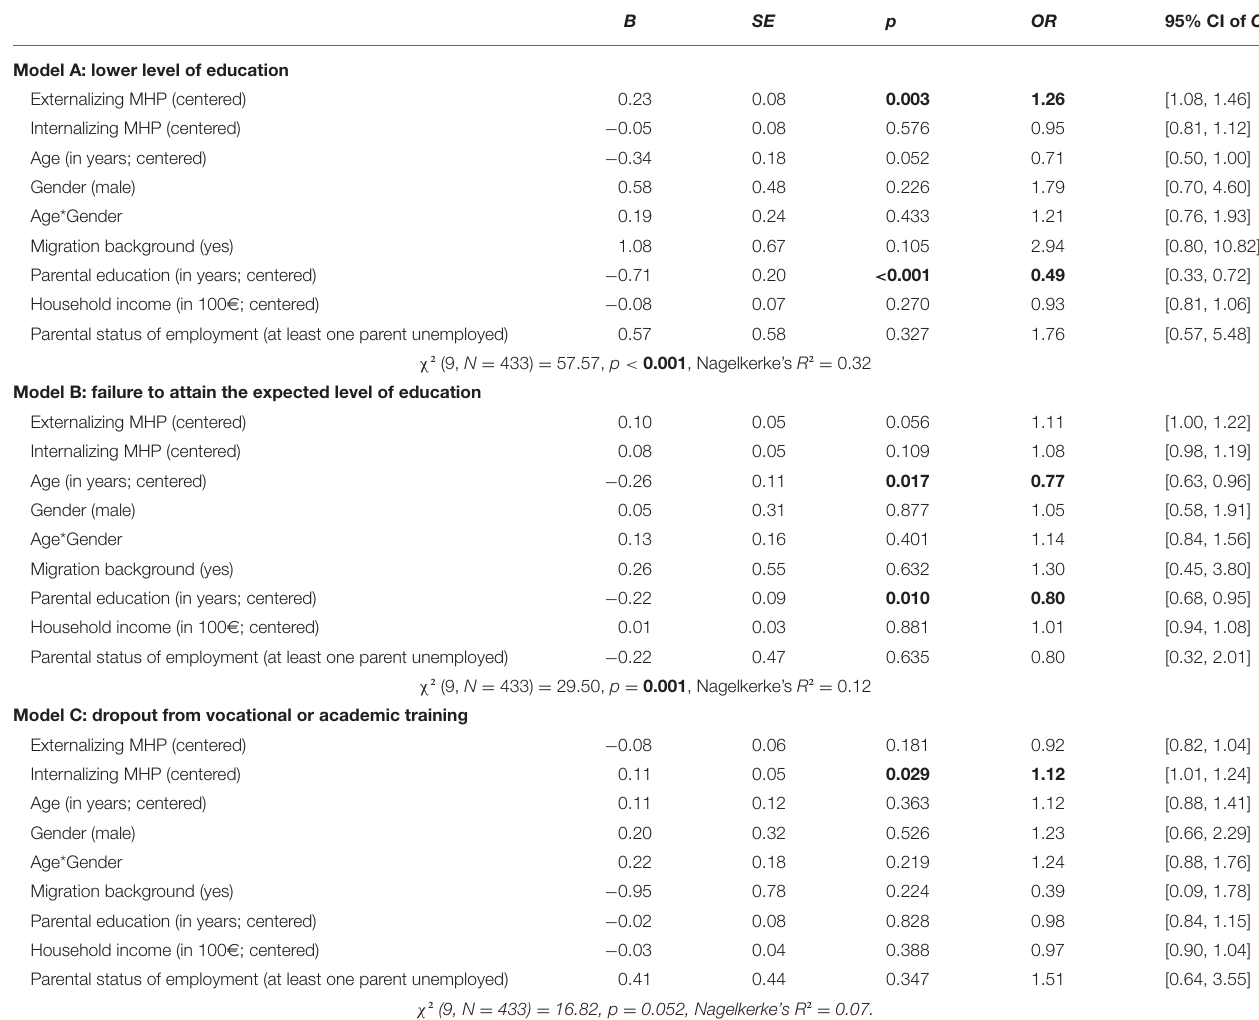
TABLE 2 | Final models predicting lower level of education (A) , failure to attain the expected level of education (B) , and dropout from vocational or academic training (C) . B SE p OR 95% CI of